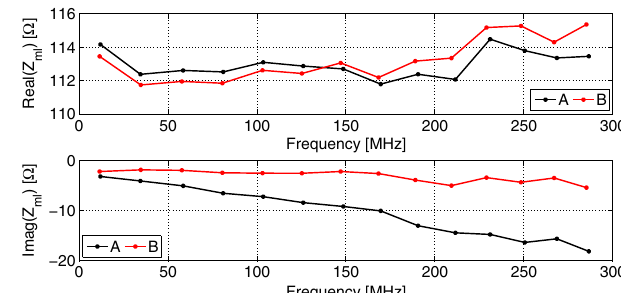
FIG. 15. Modulus and phase of S 21 meas and S 12 meas .